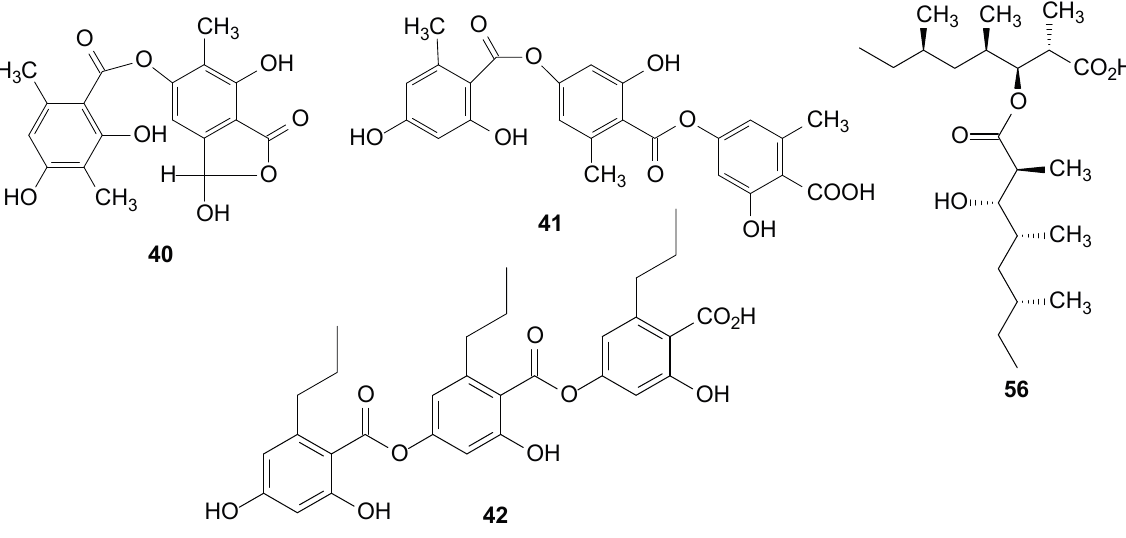
Figure 3. Chemical structures of the depsides and derivatives of the Ramalina species of lichenized